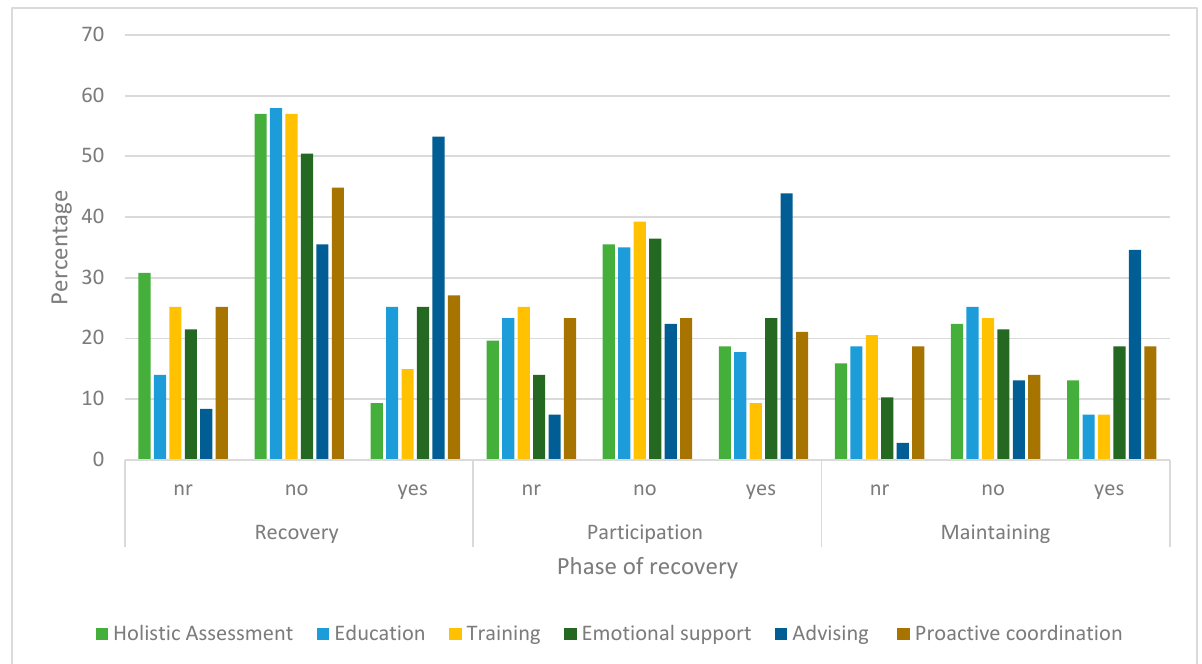
Figure 4. Generalist CM actions across the phases of recovery. Key: The action codes are: nr (not required, not considered necessary and not performed); no—intervention considered necessary but no indication intervention performed; yes—intervention evident and expected.